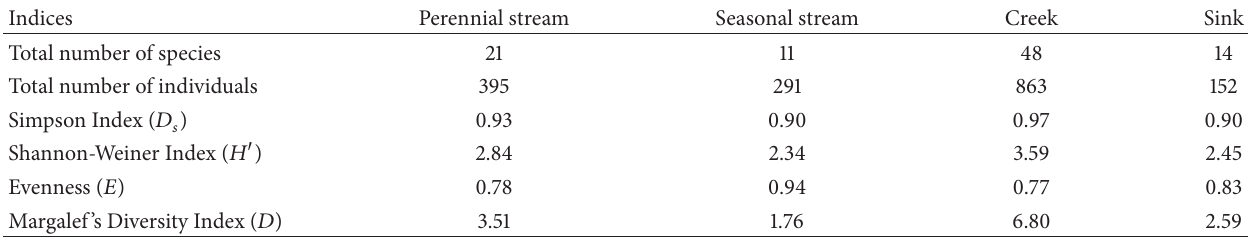
Table 7: Diversity indices of the ichthyofaunal